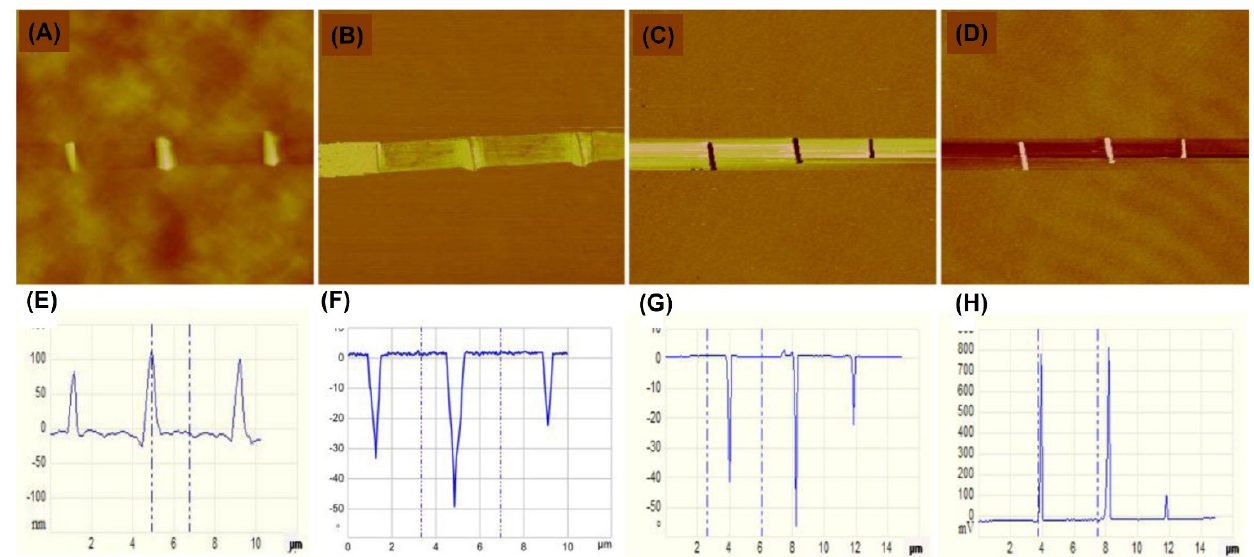
Figure 10. Magnetic force microscopy measurements on ReSe 2 . ( A ) AFM topography, ( B ) phase, ( C ) MFM phase, and ( D ) MFM amplitude images of monolayer ReSe 2 wrinkled flake on gel − film subs − trate. ( E − H ) The corresponding profiles in panels ( A − D) . Reprinted with permission from [86]. Copyright 2015, American Chemical Society.